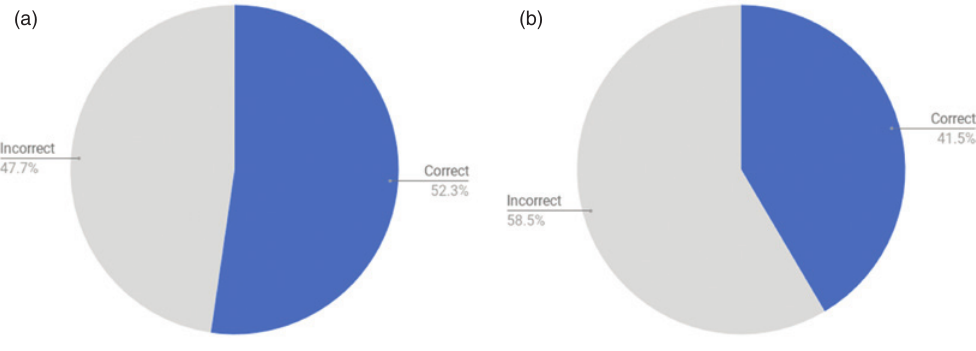
The time distribution between the CHECK and RETENTION questions was the same for both groups (Figure 6). No significant differences (Mann–Whitney, p = 0.11) were